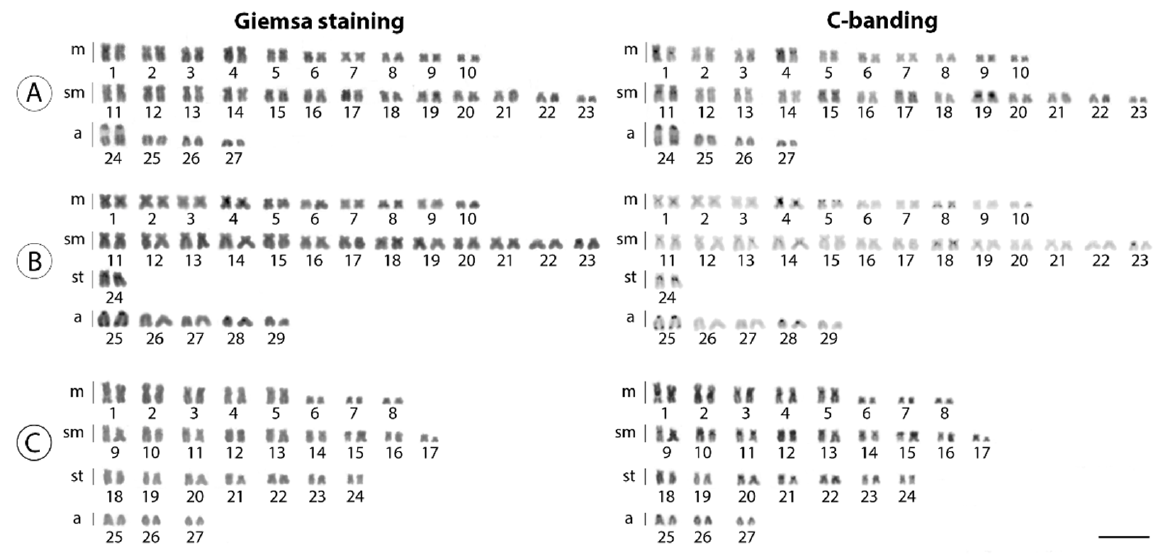
Figure 2. Karyotypes of three Harttia species arranged from mitotic metaphases after Giemsa staining, and C-banding. Harttia dissidens ( A ), H. guianensis ( B ), and Harttia sp. 3 ( C ). Scale bar = 10 µm.